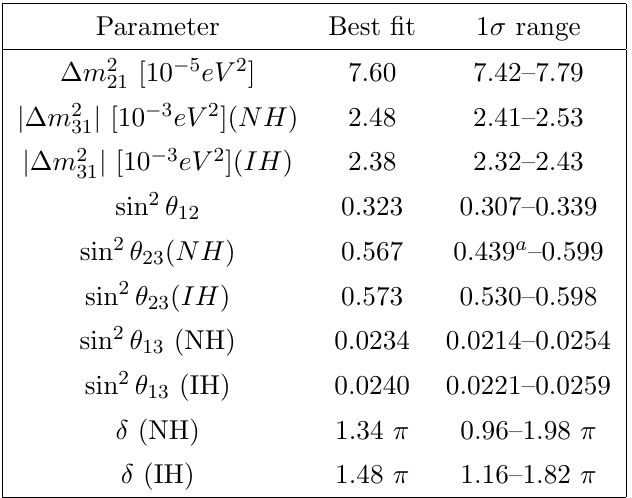
Table 1 . Neutrino oscillation parameter summary, taken from ref. [4]. For (cid:1) m 2 and (cid:14) the upper (lower) row corresponds to normal (inverted) neutrino mass hierarchy. a There is a local minimum in the (cid:12)rst octant, sin 2 (cid:18) 23 = 0 : 467 with (cid:1) (cid:31) 2 = 0 : 28 with respect to the global